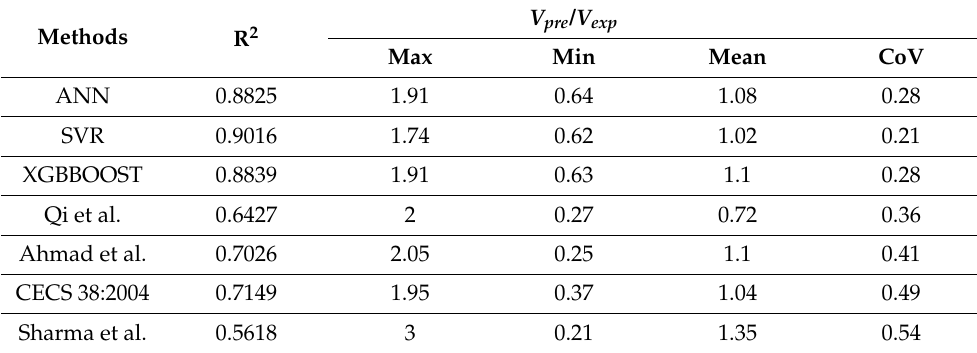
Table 2. Accuracy evaluation details of the above prediction